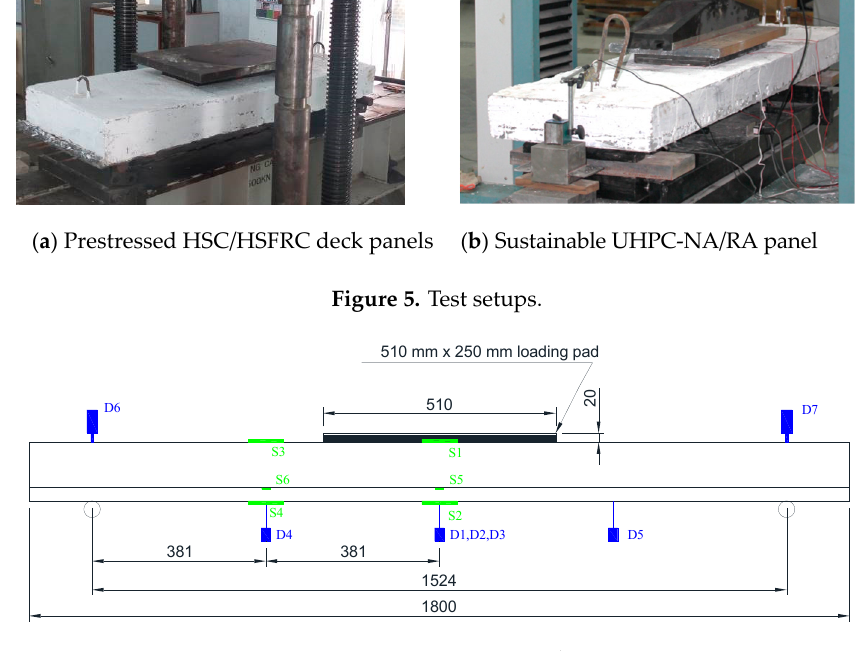
Figure 6. Instrumentation plan.